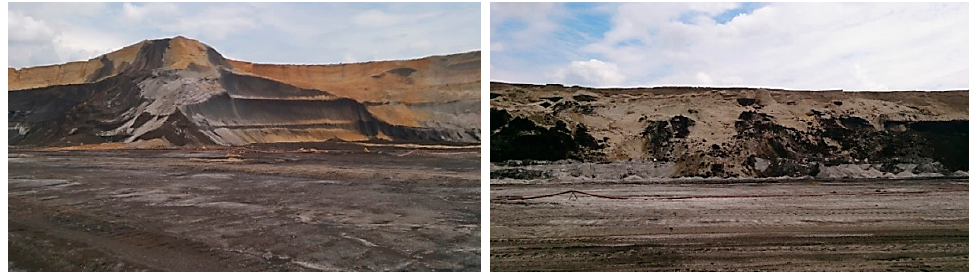
Figure 6. Complicated geology in the Profen mine (second bench).